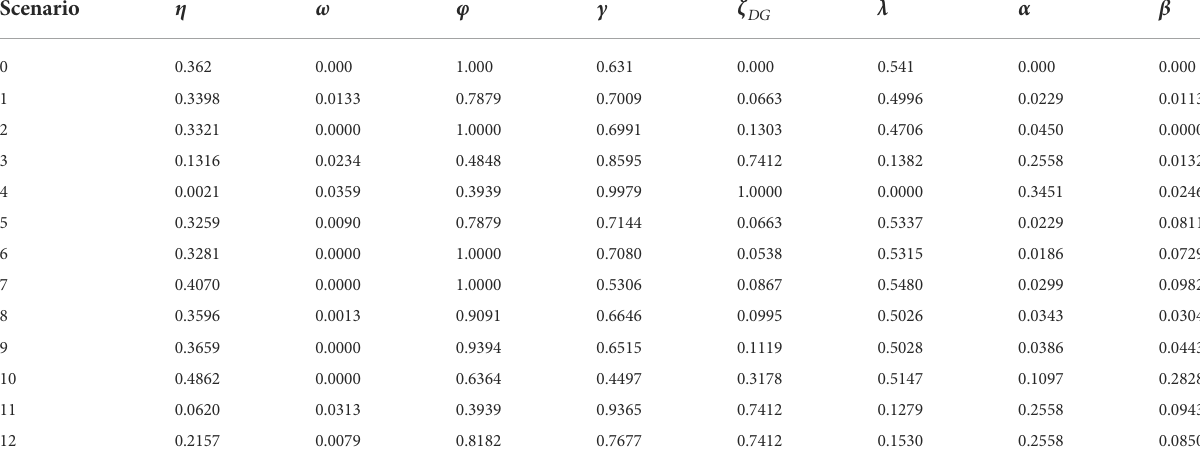
TABLE 5 Situation assessment indexes of the ADN under different cyberattack scenarios. Scenario